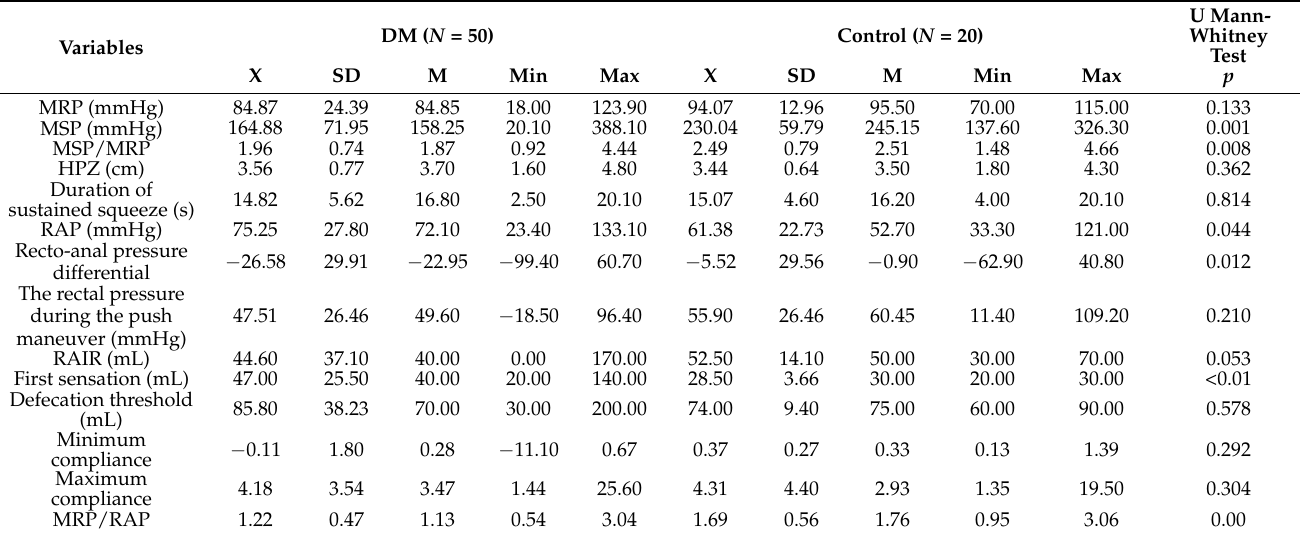
Table 6. Manometric parameters in diabetic patients and controls.